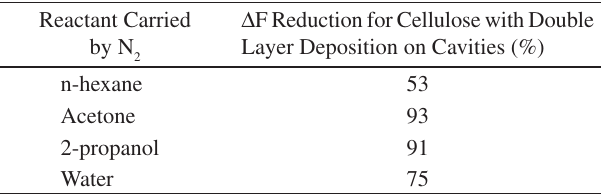
Table 5. Reduction of ∆ F (%) obtained using the cavity for thin film deposited on cellulose. Cavity without films deposited in it was used as reference.